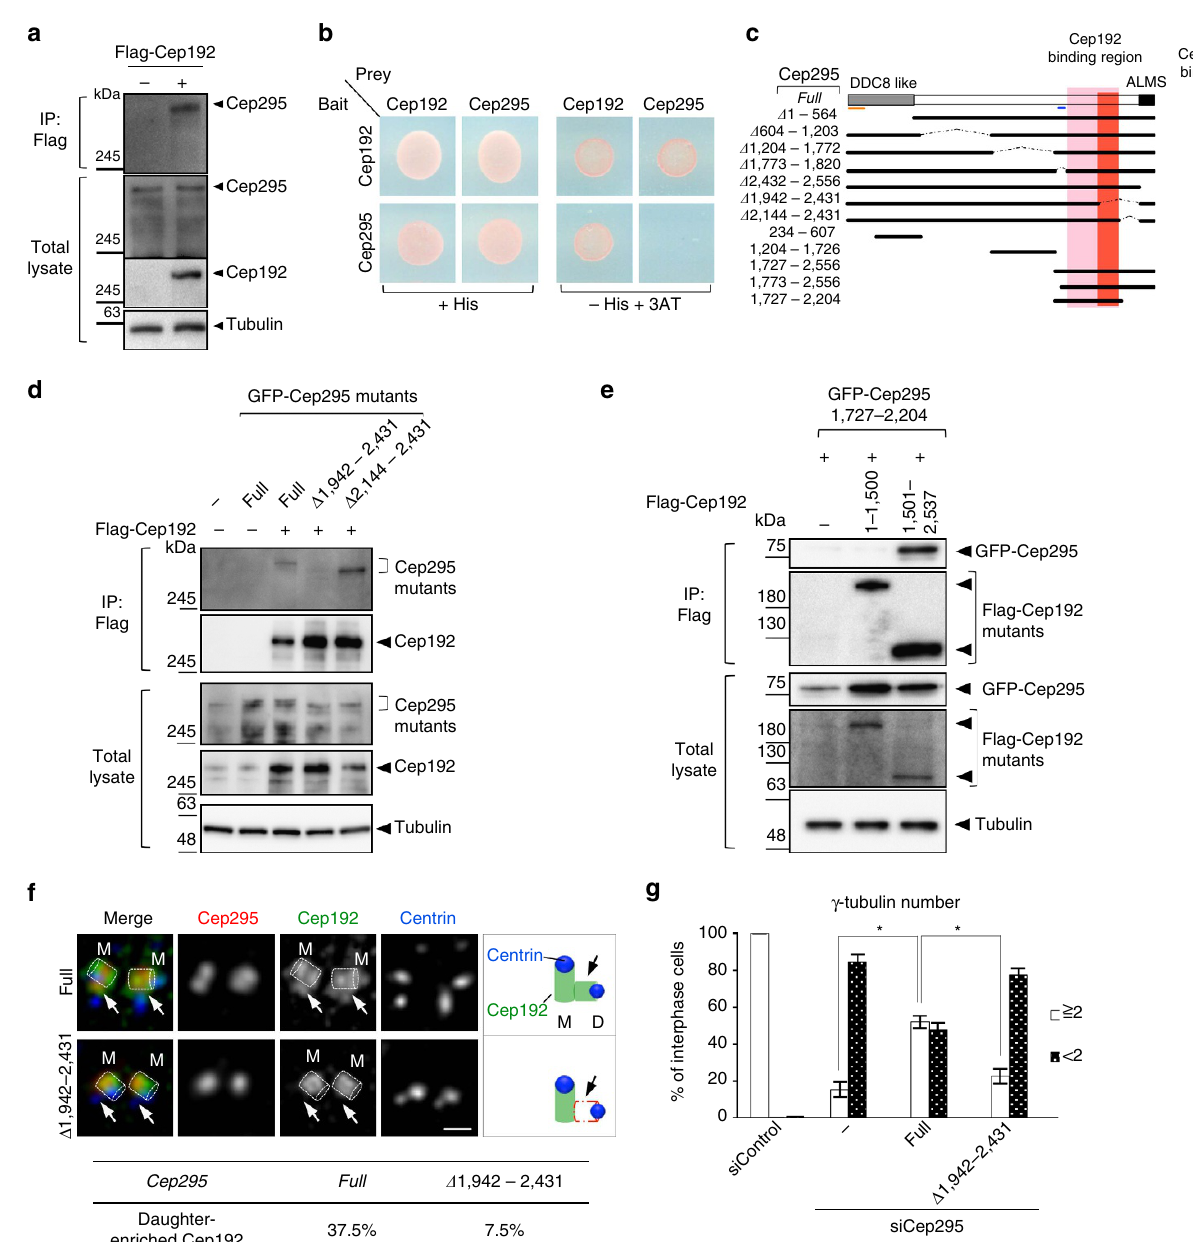
Figure 5 | Interaction between Cep295 and Cep192 is required for the recruitment of Cep192 to a newly formed daughter centriole. ( a ) Physical interaction between endogenous Cep295 and Cep192. U2OS cells were transfected with Flag-tagged Cep192 full-length for 24h. The proteins were then immunoprecipitated from cell lysates with Flag beads. Total cell lysate and immunoprecipitates (IPs) were analysed by western blotting using Flag, Cep295 or a -tubulin (loading control) antibodies. The same result was obtained in 293T cells. ( b ) Yeast two-hybrid assay showing the interaction between full-length Cep192 and full-length Cep295. The indicated clones were grown on the plates lacking histidine and containing 50mM 3-ATat 30 (cid:2) C. The same results were obtained from two independent clones for each combination. The outcome of the other clone is not shown. ( c ) Schematic of full-length Cep295 and the deletion mutants used for co-IP assays with Flag-tagged full-length Cep192 in U2OS cells. The sufficient and necessary regions for Cep192-binging in Cep295 are represented in pink and red, respectively. The DDC8-like domain, ALMS domain, and two evolutionarily conserved domains are indicated. ( d , e ) Co-immunoprecipitation assay in U2OS cells testing interaction between Flag-Cep192 and the indicated Cep295-GFP deletion mutants or between Cep295 fragment containing the Cep192-interacting region and N-terminal or C-terminal fragment of Cep192. The Flag-tagged proteins were immunoprecipitated using Flag beads from the cell lysate. Total cell lysates and IPs were analysed by western blotting using the indicated antibodies. ( f ) Three colour staining of Cep295-depleted HeLa cells expressing full-length Cep295 and the mutant protein lacking aa 1942–2431. The phenotype was analysed mostly in the first round of cell cycle ( B 48h after the RNAi treatment). The cells were analysed by TCS SP8 HSR system using antibodies against Cep192 (green), Cep295 (red) and CP110 (blue). Arrows point to the daughter centriole wall. M: mother centriole indicated as a cylinder. Scale bar, 1 m m. ( g ) For rescue experiments, Cep295-depleted HeLa cells were transfected with full-length Cep295 and the indicated mutant. Histograms represent frequency of interphase cells with the indicated number of g -tubulin foci in each condition. Values are mean percentages ± s.e.m from three independent experiments ( N 4 50 for each condition). * P o 0.05 (two-tailed t